Question: Give a one-sentence summary of this figure.
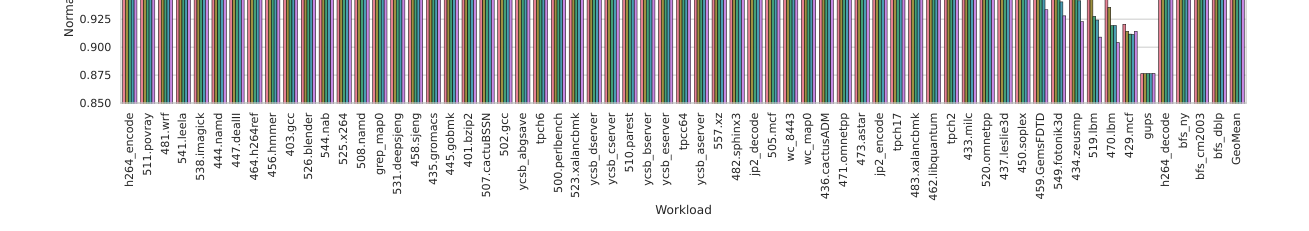
Answer: Normalized performance of single-core applications for four different physical address to DRAM address mappings (NRH = 125).